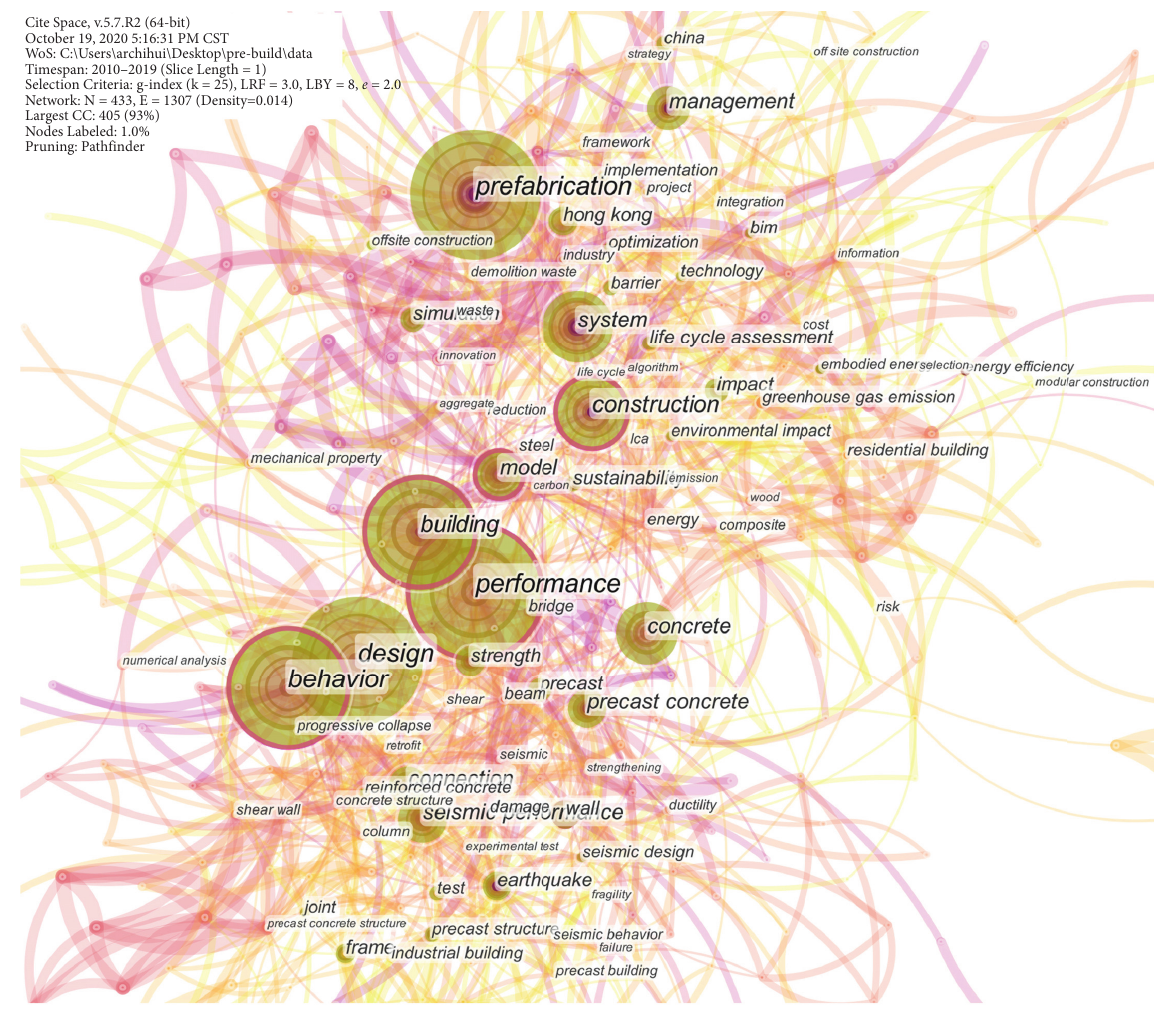
Figure 5: Co-occurring keywords’ network. Table 5: Top 26 keywords with the strongest citation